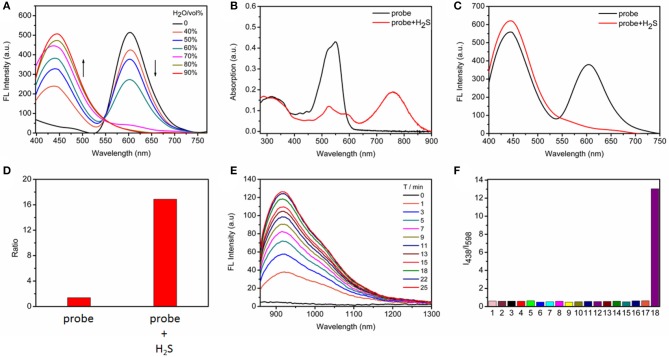
(A) Fluorescence changes of TPE-BODIPY-Cl (10 μM) in Tris/CH3CN mixtures with different water fractions. (B) Absorption and (C) fluorescence spectra in the absence and presence of 100 μM NaHS in Tris/CH3CN buffer solution (0.5 M Tris-HCl, 40% CH3CN, pH = 7.4), λex = 360 nm. (D) The fluorescence intensity ratio (I438/I598) in the absence and presence of 100 μM NaHS. (E) Time-dependent NIR-II emission spectra upon addition of 100 μM NaHS, λex = 760 nm. (F) Ratiometric fluorescence changes of TPE-BODIPY-Cl in the presence of 100 μM NaHS and other biologically relevant reactive sulfur and anions (1 mM) in Tris/CH3CN buffer solution (0.5 M Tris-HCl, 40% CH3CN, pH = 7.4): (1) Free; (2) F−; (3) Cl−; (4) Br−; (5) I−; (6) NO2-; (7) N3-; (8) HCO3-; (9) SO42-; (10) HPO42-; (11) ClO−; (12) H2O2; (13) −OAc; (14) S2O32-; (15) GSH; (16) Cys; (17) Hcy; (18) NaHS.